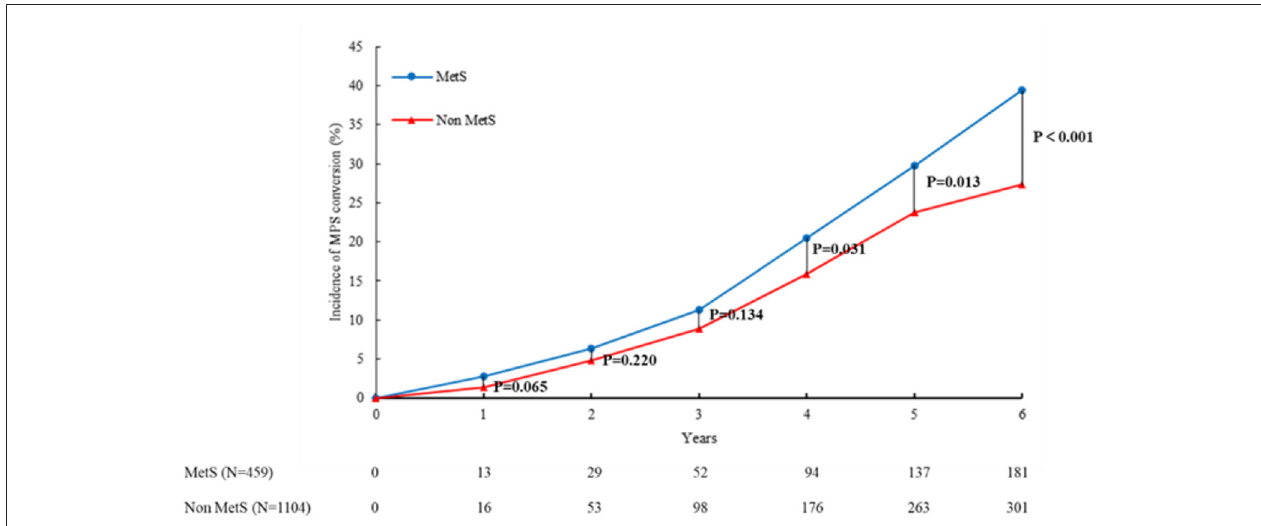
FIGURE 2 | MetS and PD conversion by age. The incidence of MPS conversion in subjects with and without MetS across the years of follow-up is shown in this figure. The incidence of MPS conversion in subjects with MetS was higher than that in subjects without MetS during the follow-up of 6 years. The incidence of MPS conversion in subjects with MetS was significantly higher than that in subjects without MetS, particularly in the 4th, 5th, and 6th years ( p < 0.05). MetS, metabolic syndrome; MPS, mild parkinsonian